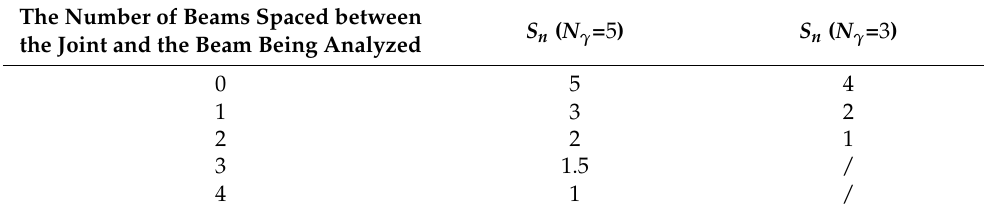
Table 3. S n values representing the influencing extent of joint-n on the LLDF of beam- i . The Number of Beams Spaced between